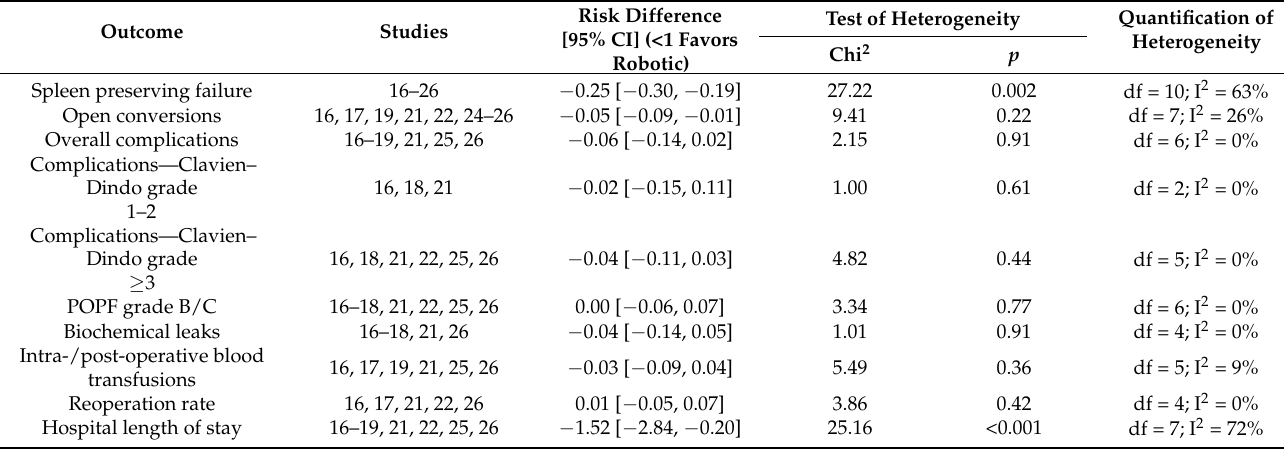
Table 3. Risk differences between robotic and laparoscopic spleen-preserving distal pancreatectomies. CI: confidence interval; POPF: postoperative pancreatic fistula.